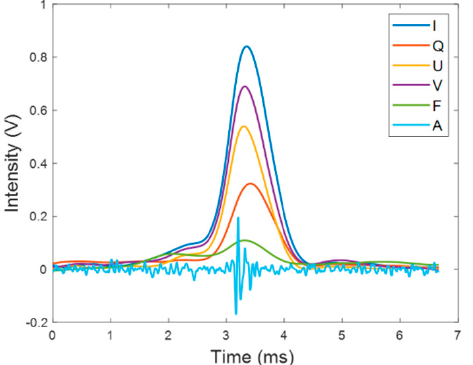
Figure 3. Simultaneously recorded temporal optical signals ( I , Q , U , V , F ) and acoustic signal (marked as A ).